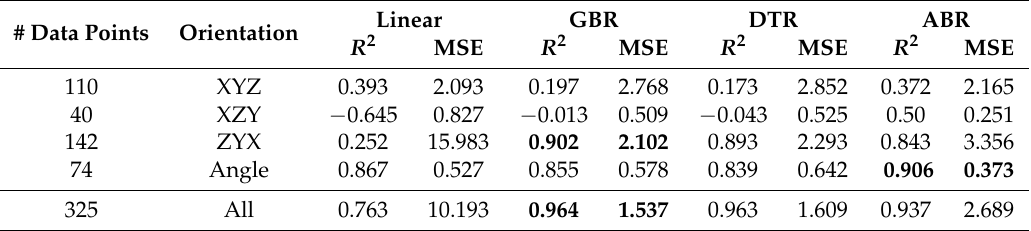
Table 6. Prediction of Nominal Stress with the help of machine learning techniques. Linear means linear regression models, GBR stands for Gradient Boost Regressor, DTR for Decision Tree Regressor, and ABR for AdaBoost